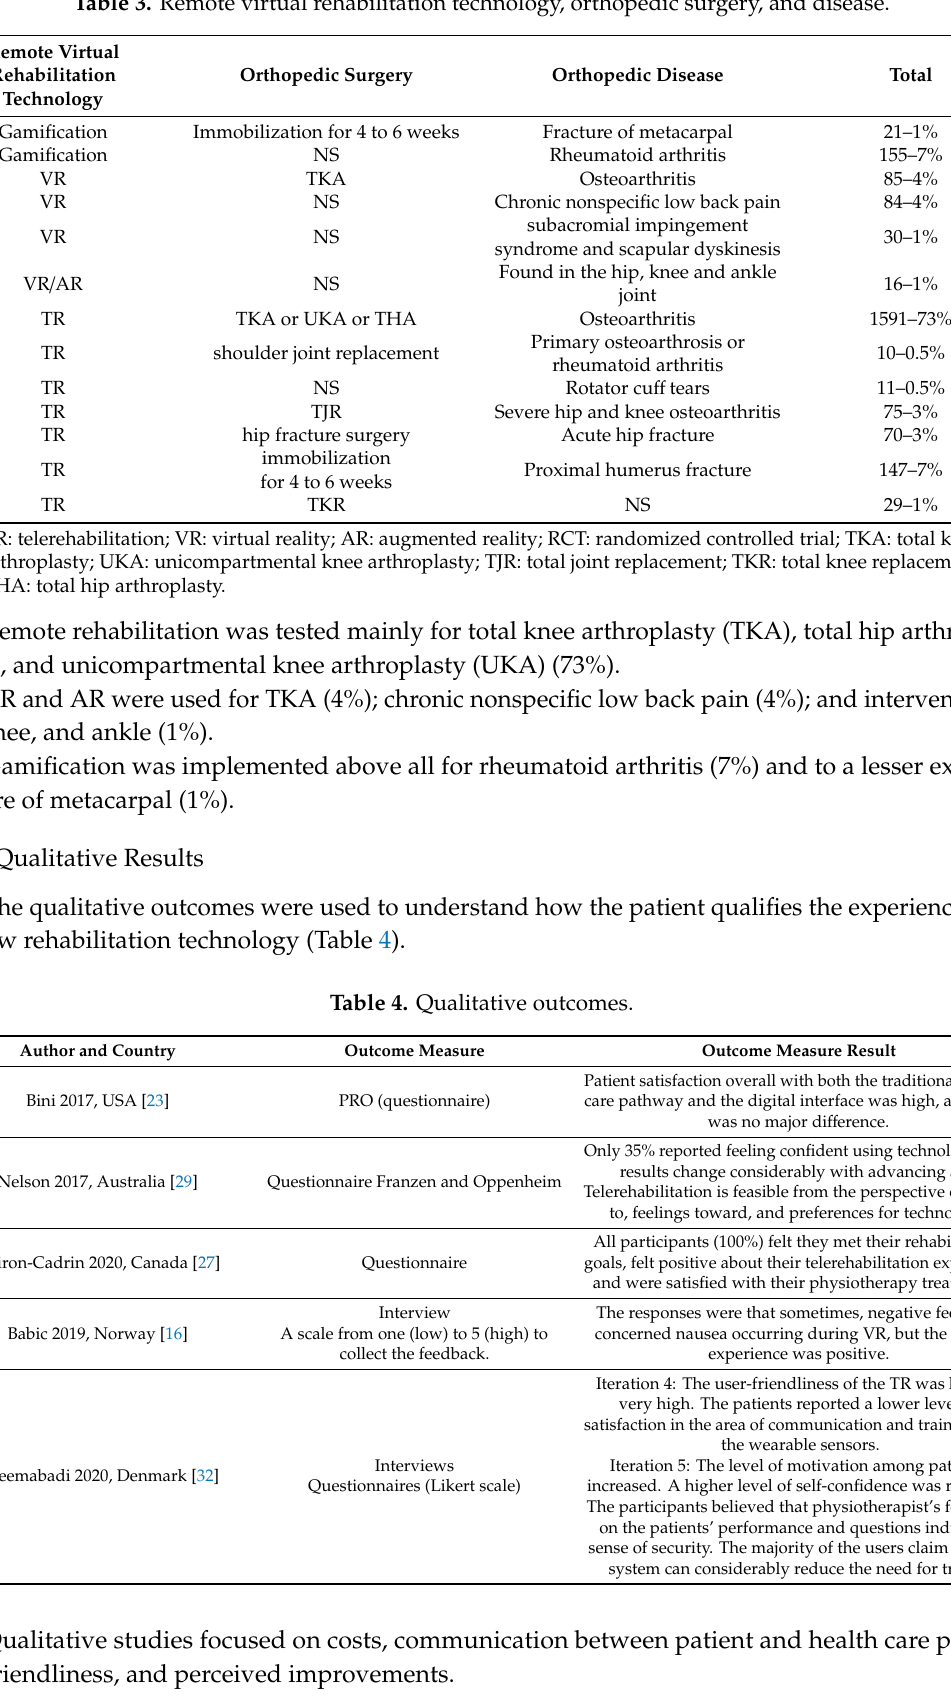
Table 3. Remote virtual rehabilitation technology, orthopedic surgery, and disease.